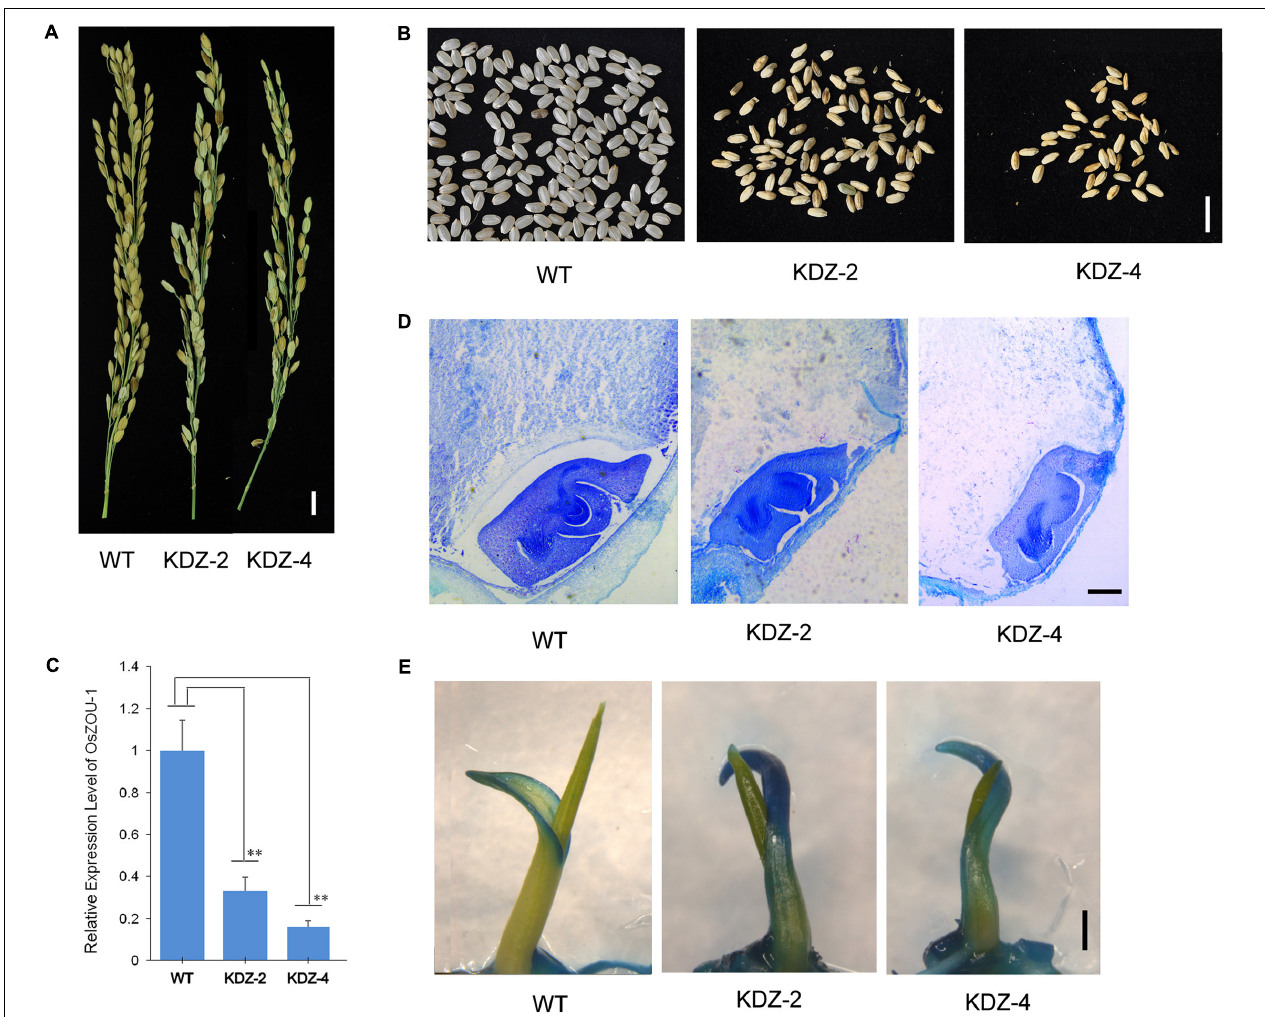
FIGURE 5 | Phenotype of OsZOU-1 knock-down lines. Three homozygous plants from the knock-down lines KDZ-2 and KDZ-4 were used for phenotype and molecular analyses, but only one image from each is presented here. (A) Spikes of OsZOU-1 knock-down transgenic lines with fewer full seeds compared to the WT line. Scale bar = 1cm. (B) Mature seeds from the WT line and the knock-down lines KDZ-2 and KDZ-4. Scale bar = 1 cm. (C) Relative expression levels of OsZOU-1 in WT seeds five DAP and in the knock-down lines KDZ-2 and KDZ-4 were examined using qRT-PCR analysis. Expression values for each line are averages for three plants; the expression level of OsZOU-1 in WT seeds was set as 1. Error bars correspond to the SD calculated from three biological replicates, and OsActin1 was used as the reference gene. Student’s t -test value: ∗∗ p < 0.01. (D) Cross sections of WT and KDZ seeds at 12 DAP. Scale bars = 100 µ m. (E) WT seedlings, KDZ-2, and KDZ-4 on the third day after germination were stained with TB. Just the margin of the coleoptile was weakly stained in WT seedlings, while the whole coleoptile in KDZ-2 and KDZ-4 was strongly stained. Scale bars = 1